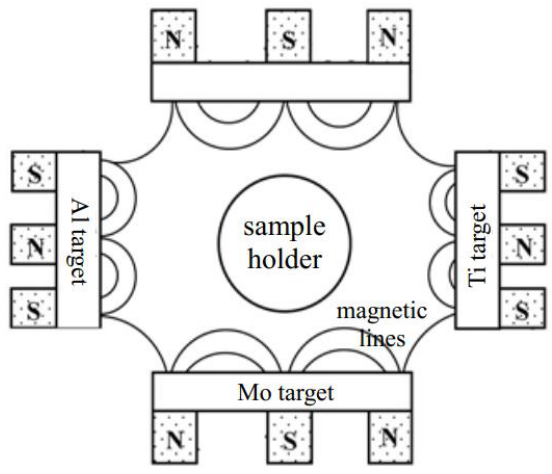
Figure 3. Layout of MSIP-016 sputtering chamber.